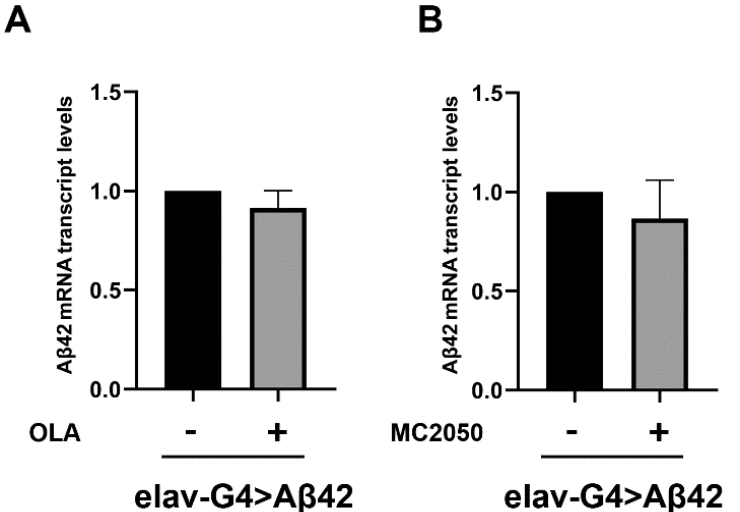
Figure 3. ( A , B ) qRT-PCR analysis assessing induction levels of the A β 42 transgenic construct by elav-Gal4. cDNA was prepared from total RNA purified from AD ( elav-Gal4 > A β 42 ) head tissues treated (or not) with PARP-1 inhibitors. The constitutive rp49 was examined as an endogenous control. The data are expressed as “fold enrichment” with respect to elav-Gal4/+ and represent the mean ± SEM of three independent experiments. Statistical analysis, determined by unpaired t-test, showed no significant difference between means.